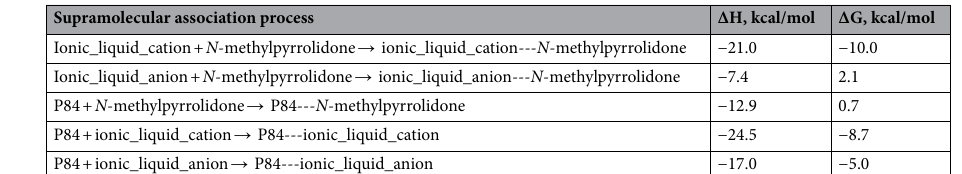
Table 3. Calculated values of enthalpies and Gibbs free energies of reaction (ΔH and ΔG) for various hypothetical supramolecular association processes.